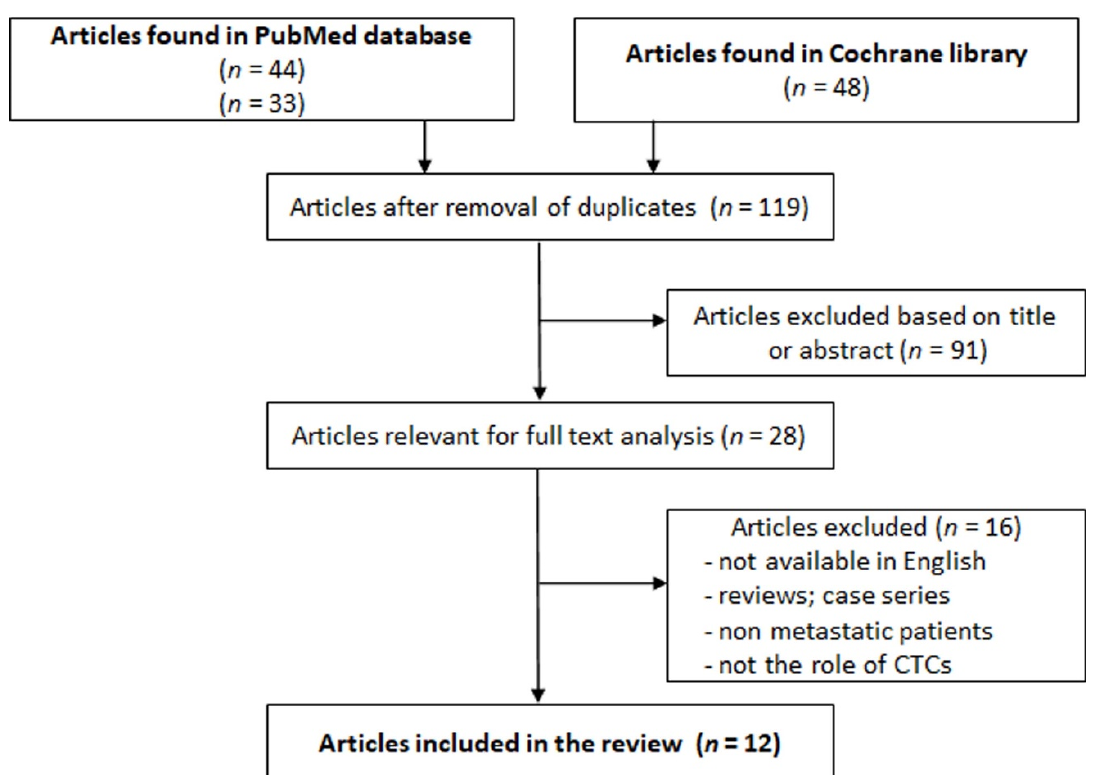
Figure 1. Study selection flow chart. CTCs: circulating tumor cells.